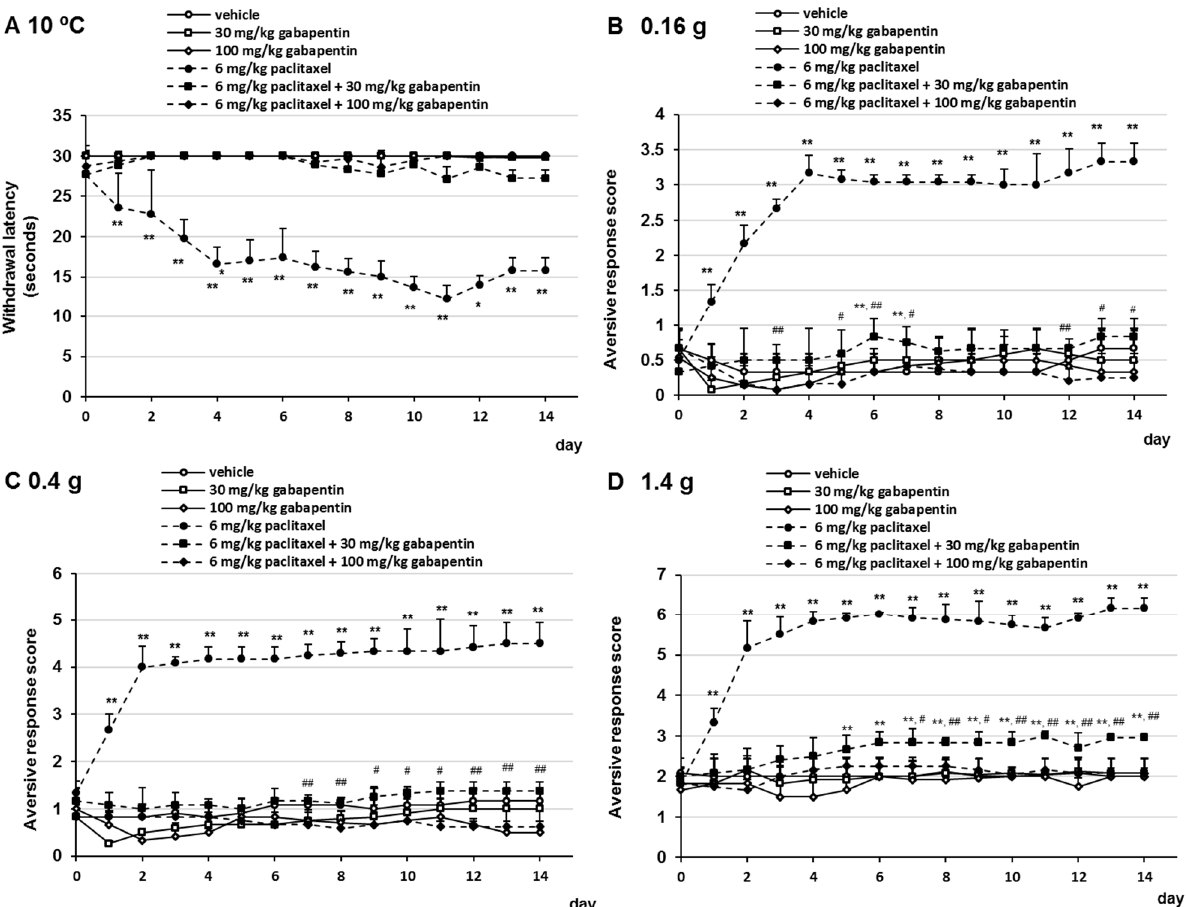
Figure 2. Inhibitory effect of gabapentin on paclitaxel-induced mechanical allodynia in mice. Paclitaxel (6 mg/kg, i.p.) was administered on days 0 and 7, and gabapentin (30 or 100 mg/kg, p.o.) was administered daily from days 0 to 14. ( A ) Withdrawal latencies, presented as means ± standard deviations (S.D.), represent the time taken by mice to withdraw their hind paws following cold stimulation (10 °C) ( n = 7 per group). * p < 0.05, ** p < 0.01 vs. vehicles (Shapiro–Wilk test and Kruskal–Wallis test followed by the Scheffe test). ( B – D ) The number of paw lifts elicited by five mechanical stimulations using von Frey filaments corresponding to ( B ) innocuous (0.16 g), ( C ) intermediate (0.4 g), and ( D ) noxious (1.4 g) bending forces. The aversive response score was calculated based on two paw lifts ( n = 7 per group). * p < 0.05, ** p < 0.01 vs. vehicles, # p < 0.05, ## p < 0.01 vs. 6 mg/kg paclitaxel + 30 mg/kg gabapentin (Shapiro–Wilk test and one-way analysis of variance (ANOVA) with the Tukey test).